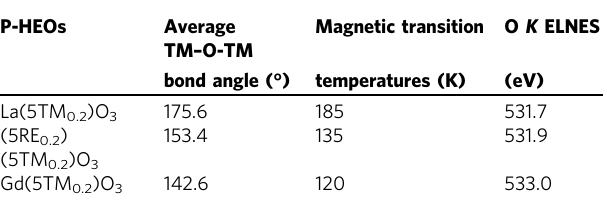
Table 1 A summary of the average TM – O – TM bond angle, magnetic transition temperatures and O K ELNES of the three